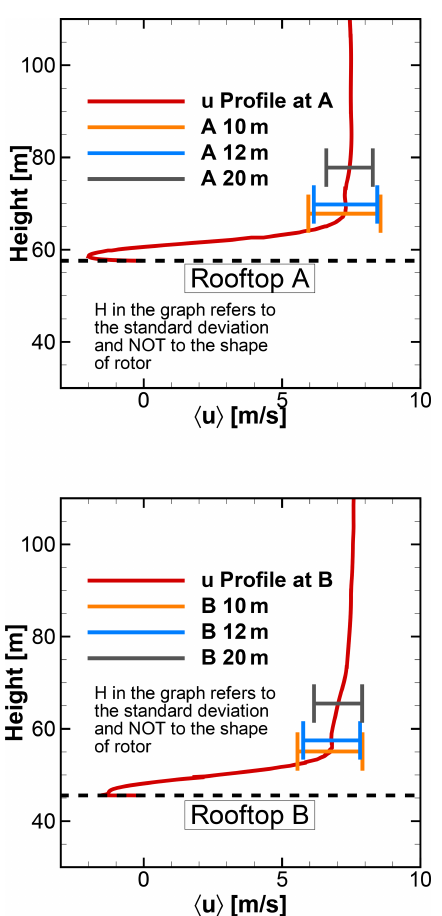
Figure 11. Mean velocity profile and standard deviations at posi- tions above rooftops of A and